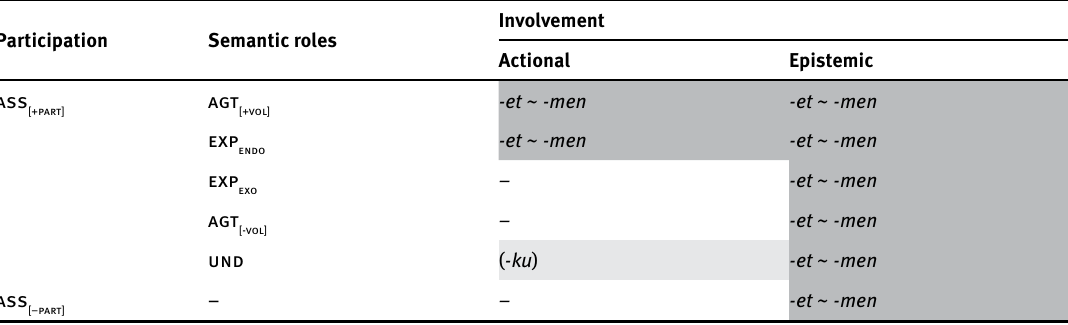
Figure 8. Modeling Bunan past egophoricity markers